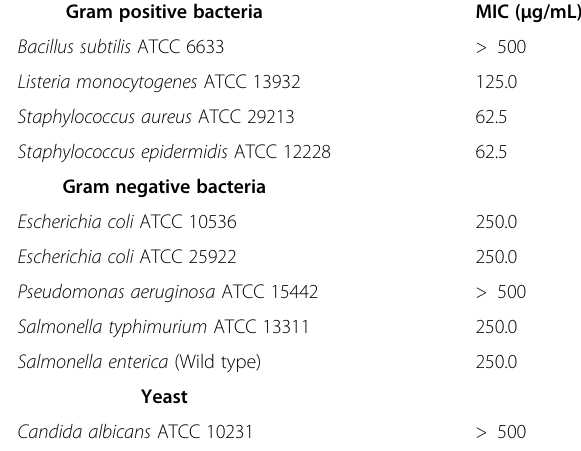
Table 3 The MIC values of F. vasta leaves extract